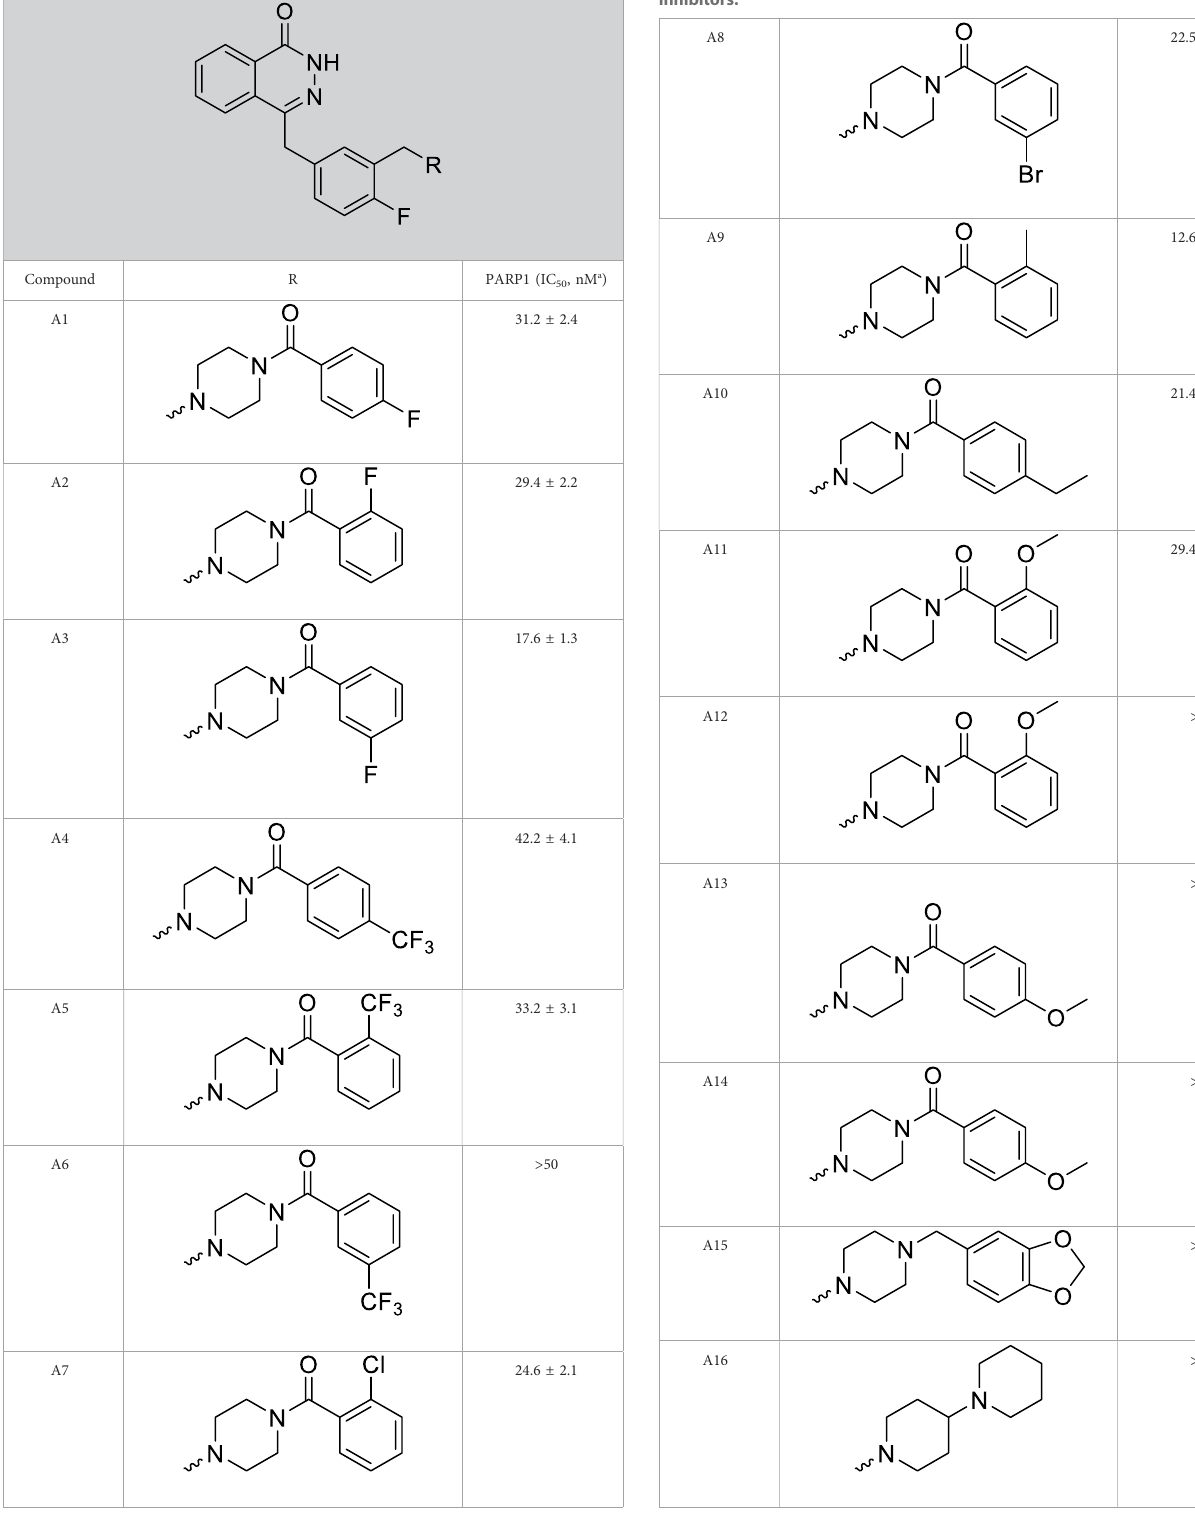
TABLE 1 Structure and PARP1 inhibitory activities of A series PARP inhibitors. TABLE 1 ( Continued ) Structure and PARP1 inhibitory activities of A series PARP